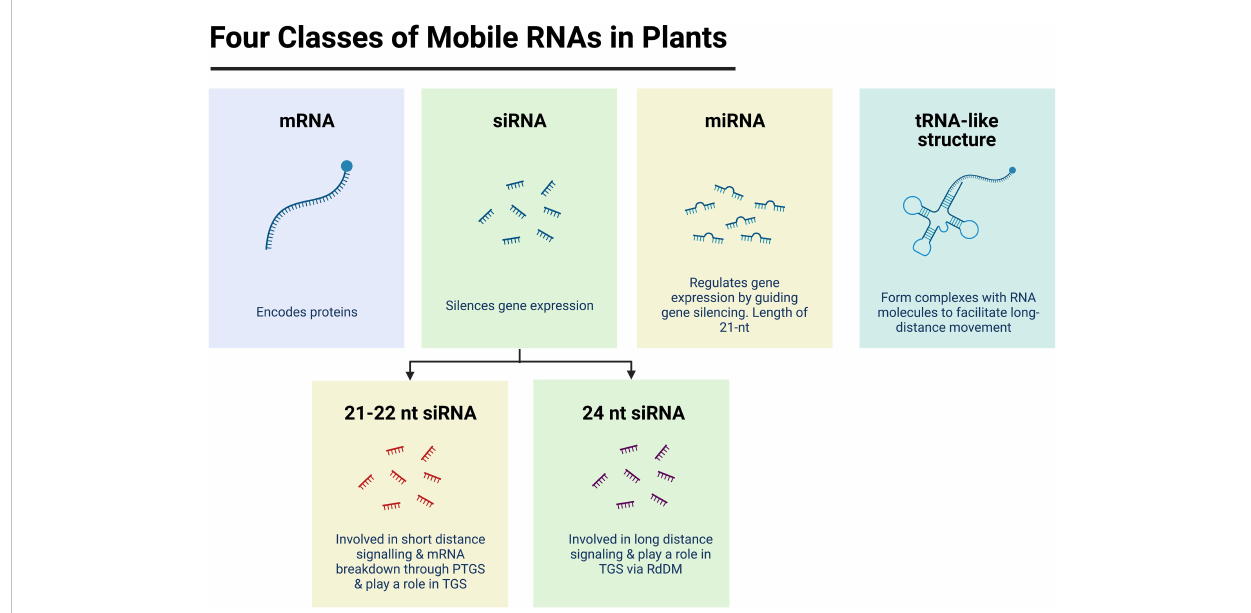
FIGURE 1 Four classes of mobile RNA molecules in plants. Potential mobile RNA molecules include messenger RNA (mRNA) molecules which encode proteins; transfer RNA (tRNA) -like structures which are associated to movement of RNA molecules; micro RNA (miRNA) which regulate gene expression by guiding gene silencing mechanisms such as Post Transcriptional Gene Silencing (PTGS) and small interfering RNAs (siRNA) which mediate the silencing of gene expression through PTGS and/or through Transcriptional Gene Silencing (TGS) via the RNA-directed DNA methylation pathway (RdDM). Figure created with